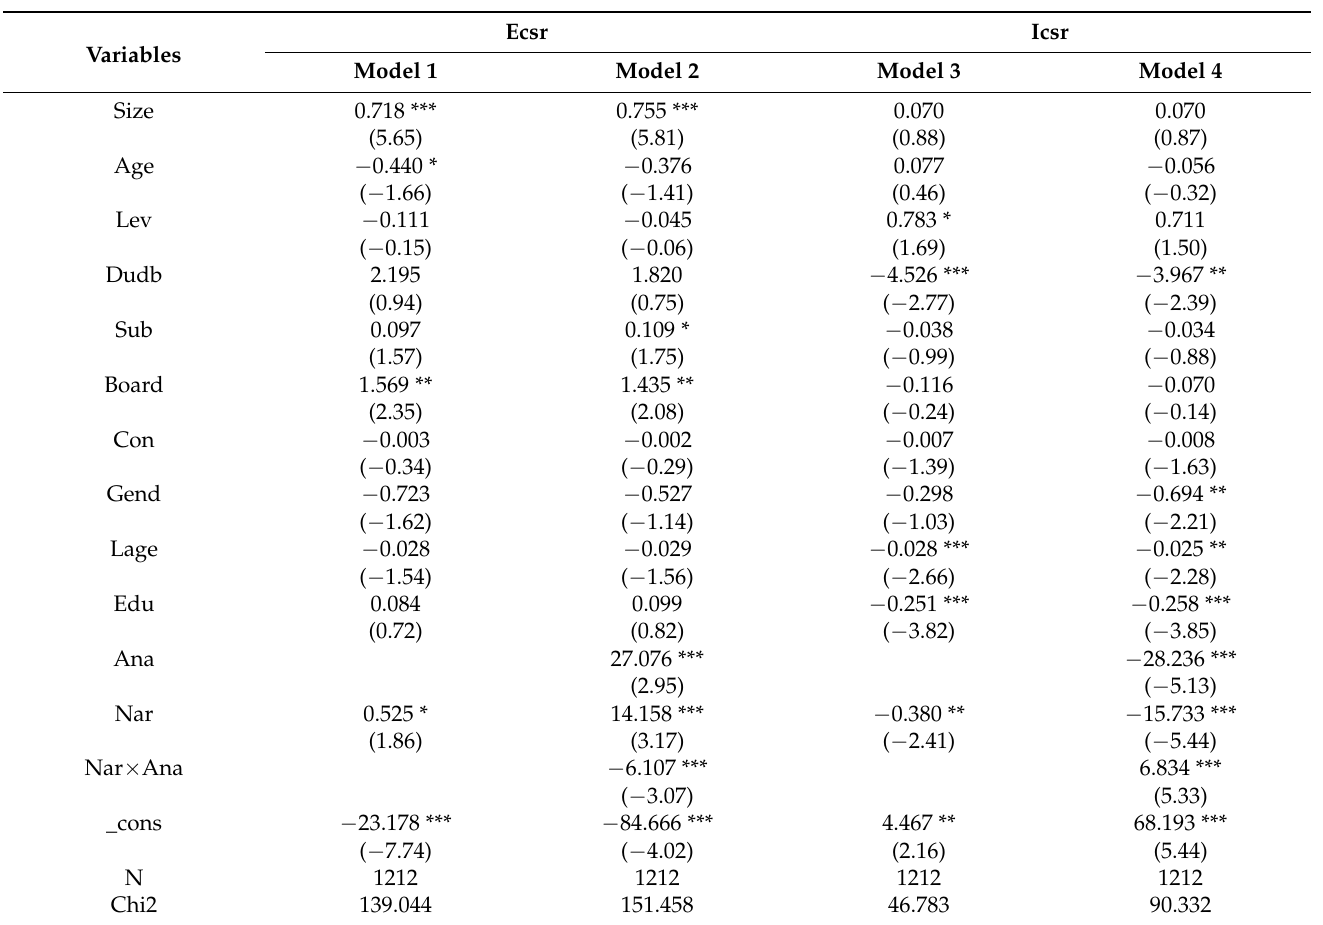
Table 6. Robustness